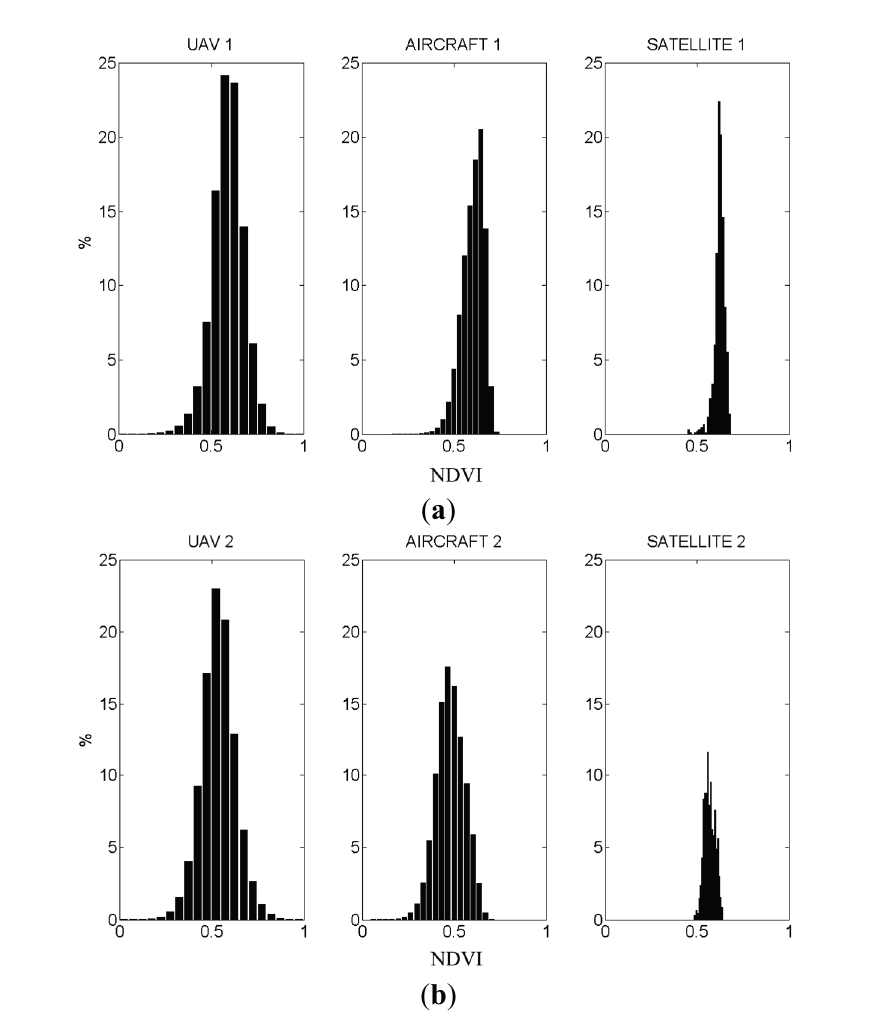
Figure 1. ( a ) V1 NDVI histogram as percentage of total values; and ( b ) V2 NDVI